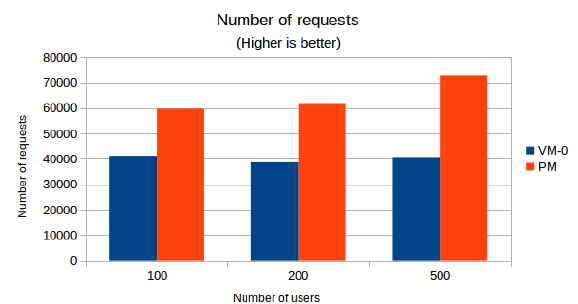
Figure 9. Median response time in milliseconds for the DescribeSensor request with 100, 200 and 500 concurrent users both for the VM-0 and PM.